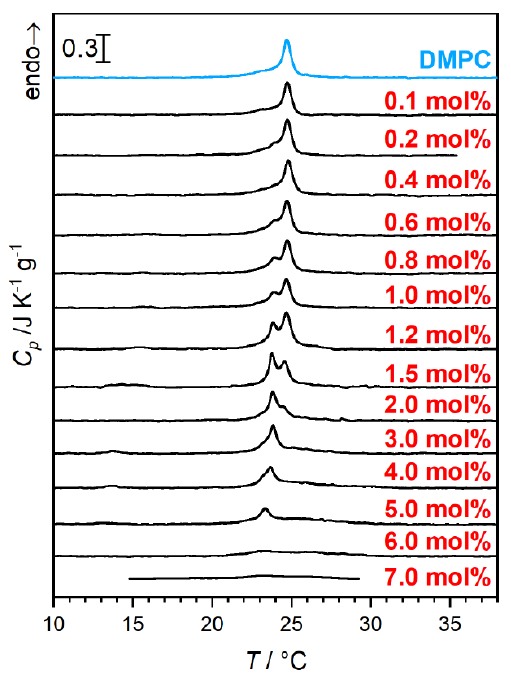
Figure 10. DSC of β -aescin containing samples. The red numbers denote β -aescin concentration in mol% with respect to the molar amount of used DMPC. An increasing β -aescin concentration enhances phase segregation and shows in the formation of a second peak at lower temperature. The experimental procedure is given elsewhere [21,48,55]. Adapted from Ref. [48] with permission of